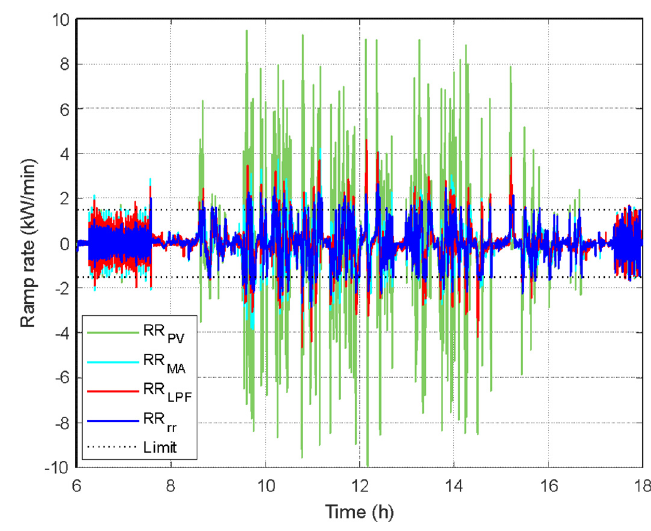
Figure 9. Rate of change of the energy injected into the point of common coupling (PCC), most critical day.